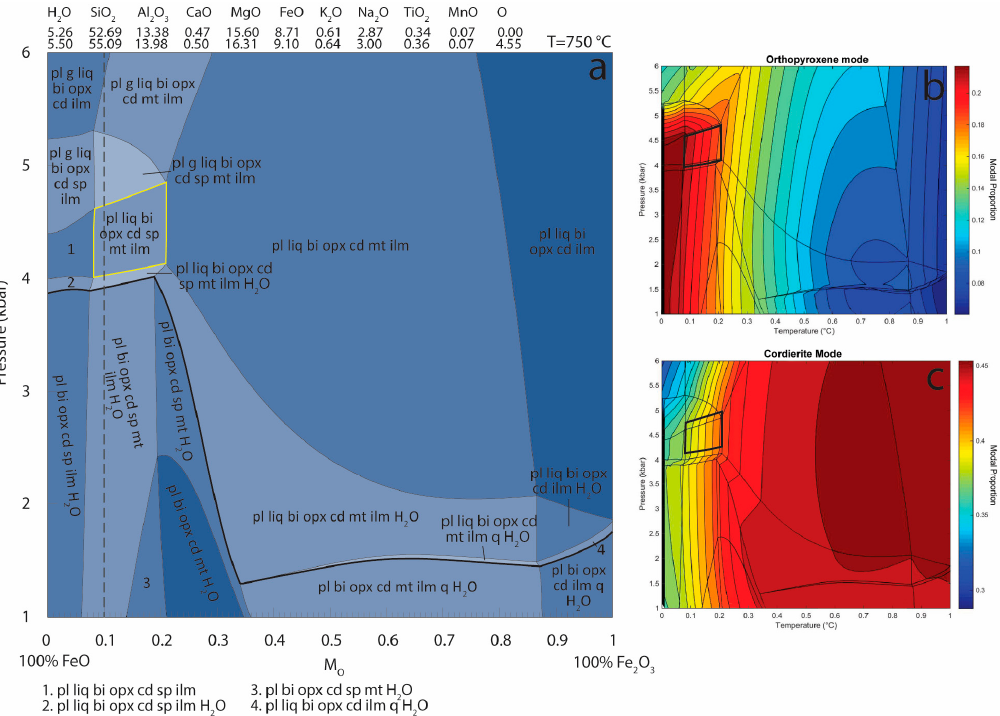
Figure A1. ( a ) P–M O model calculated to constrain the oxidation state of sample 14-RDC-04. The bold line represents the solidus. The field outlined in yellow represents the peak assemblage observed in the sample. The dashed line is the composition on the x-axis that was chosen for further modelling. ( b ) TCI output of modal proportion of orthopyroxene. The peak field is outlined in bold. ( c ) TCI output of modal proportion of cordierite. The peak field is outlined in bold.